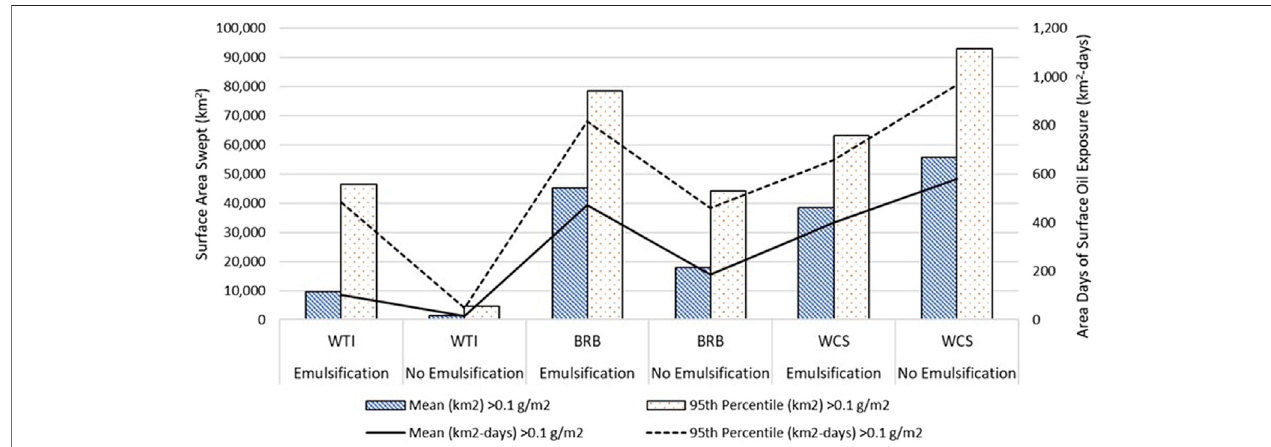
FIGURE 4 | The mean and 95th percentile surface area swept (km 2 ) and area-days of surface oil exposure (km 2 -days) ≥ 0.1 g/m 2 threshold for each stochastic scenario (i.e., all oils with and without emulsi fi